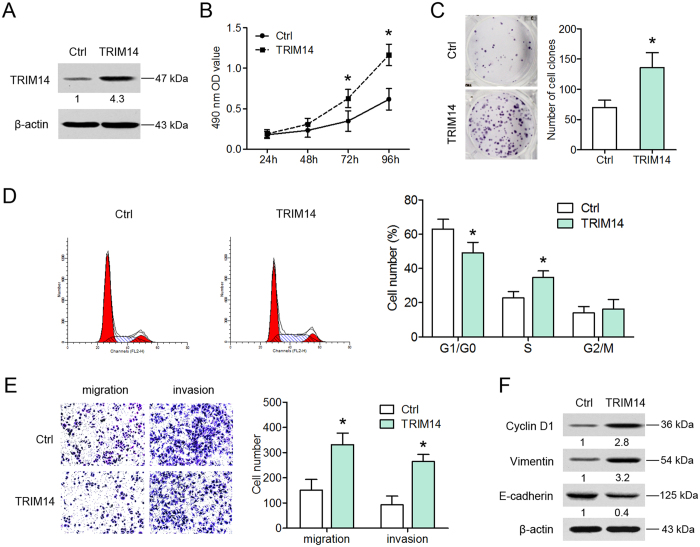
Overexpression of TRIM14 promotes osteosarcoma cell proliferation, migration and invasion.(A) Saos-2 cells were infected with TRIM14-expressing (TRIM14) or control lentivirus (Ctrl), and TRIM14 protein levels assessed using western blot. (B) Cell viability was measured on the indicated days using the MTT assay. (C) Representative micrographs (left) and quantification (right) of osteosarcoma cell colonies detected with the colony formation assay. (D) Flow cytometry analysis of cell cycle progression in osteosarcoma cells. (E) Cell migration and invasion were determined via Transwell assays. Representative images (left) and quantification (right) of the migration and invasion assays in the indicated cells. (F) Western blot analysis of cyclin D1, vimentin and E-cadherin protein expression. *P < 0.05.